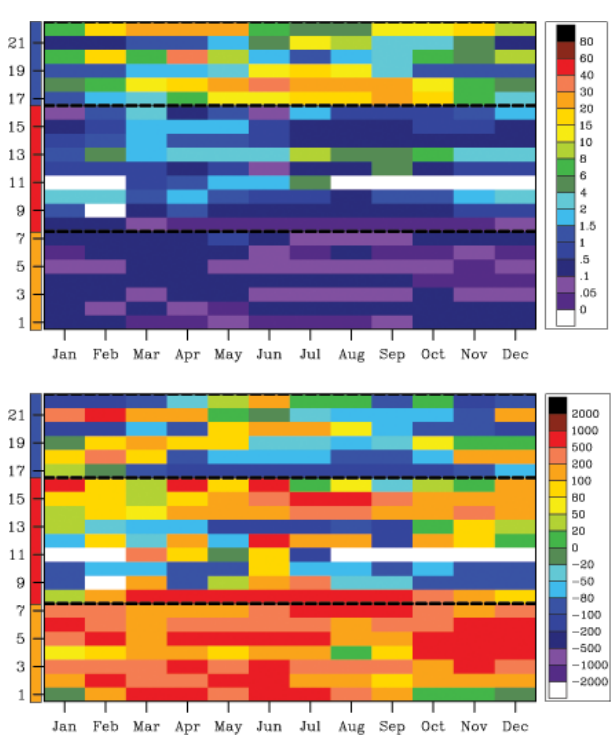
Fig. 11. Observed monthly mean surface dust mass concentrations (µgm − 3 , upper panel) and biases (%, lower panel) of modelled to observed dust concentration at 22 sites from the extended University of Miami dataset. The ordinate refers to the number of sites and colors are corresponding to the three groups as in Figs. 8 and 9: remote sites (orange), sites under influences of dust sources (red) and sites downwind the major dust sources (blue). Name, latitude and longitude of each site are listed in Table 6. Blank bars indicate missing